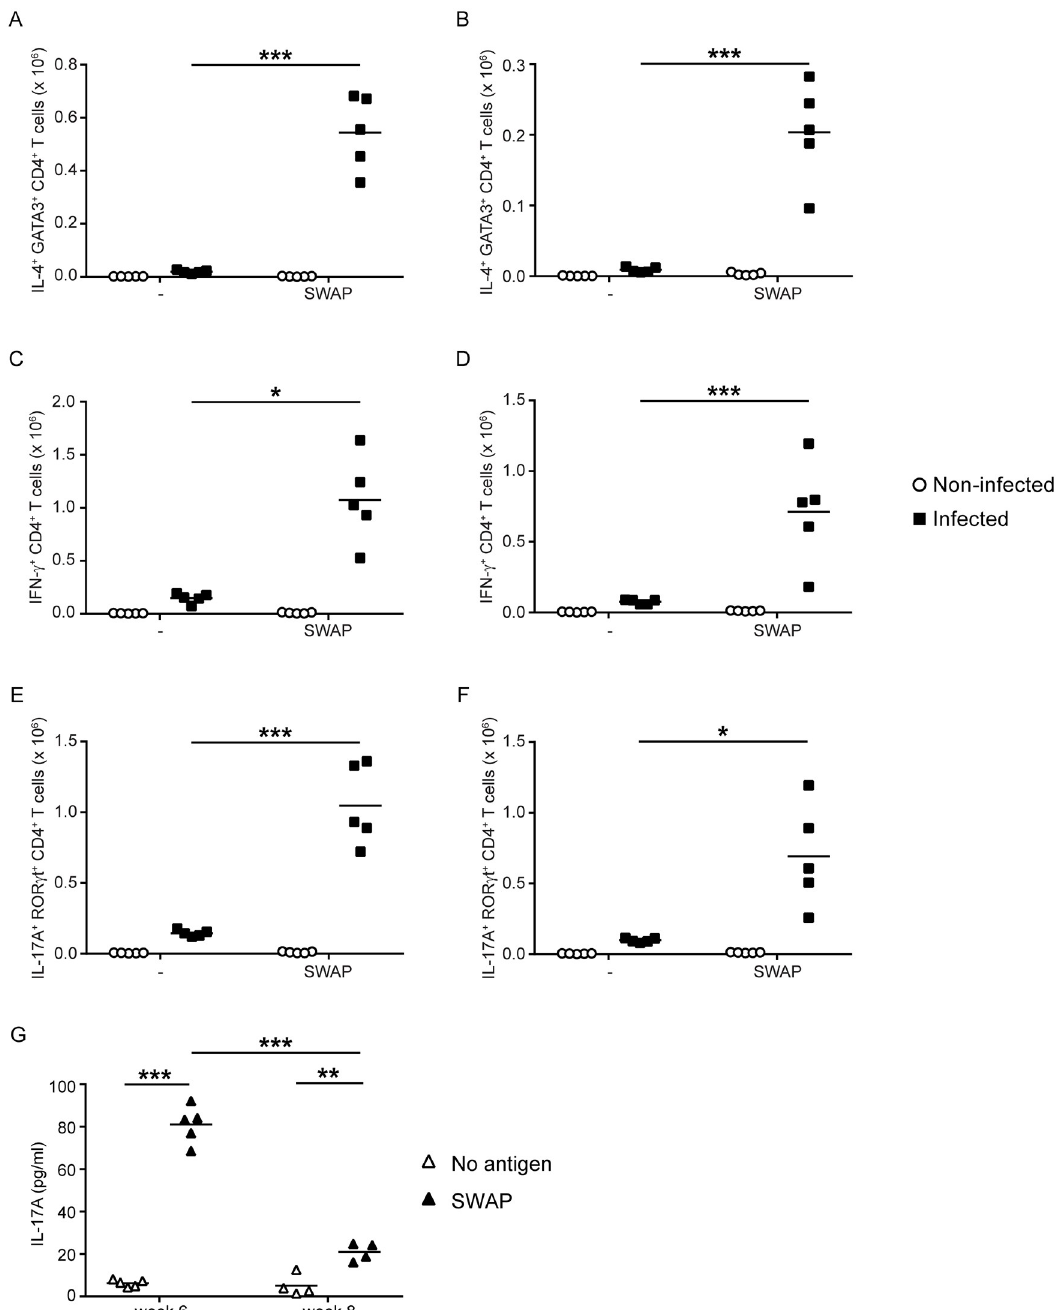
Fig 6. T H 2, T H 1 and T H 17 cells induced by acute schistosome infection proliferate and produce cytokine in response to schistosome worm antigens. At 6 weeks post infection, cells from the spleens (A, C, E) and mesenteric lymph nodes (B, D, F) of S . mansoni -infected mice were cultured in vitro in the absence (-) or presence of S . mansoni worm antigens (SWAP). Spleen and mesenteric lymph node cells from non-infected mice were included as controls and cultured under identical conditions. After three days in culture, intracellular cytokine/transcription factor staining and flow cytometry were used to determine the number of IL4 + GATA3 + CD4 + T cells (A, B), IFN- γ + CD4 + T cells (C, D), and IL-17A + ROR γ t + CD4 + T cells (E, F) in the cultures. G, spleen cells from mice that were infected with S . mansoni for 6 and 8 weeks were cultured in vitro either in the presence or absence of S . mansoni worm antigens (SWAP). After three days of culture, the concentration of IL-17A in the culture supernatant was determined by ELISA. � , P < 0.05; �� , P < 0.01; ��� , P < 0.001.